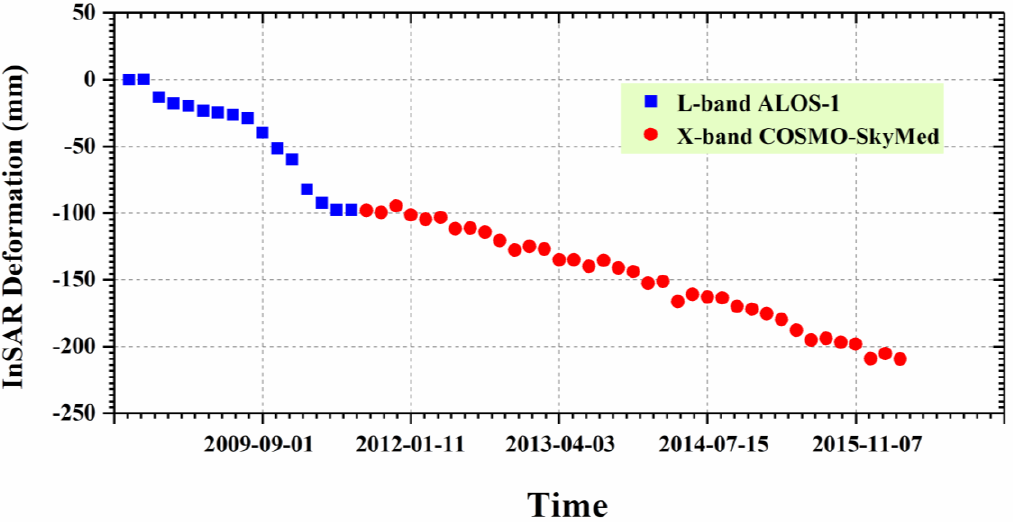
Figure 12. Time series deformation at point P1 marked in Figures 10 and 11. The blue squares and red circles represent deformation for the L-band and the X-band, respectively.